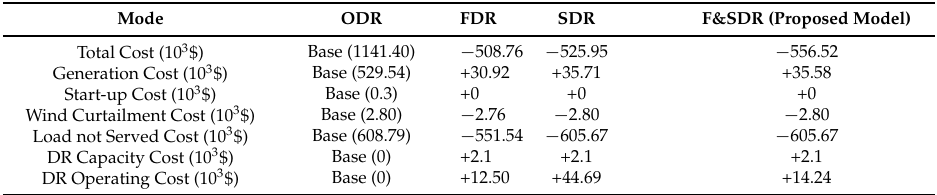
Table 6. DR scheduling modes impact on cost ( wind power profile 1): With transmission constraint.